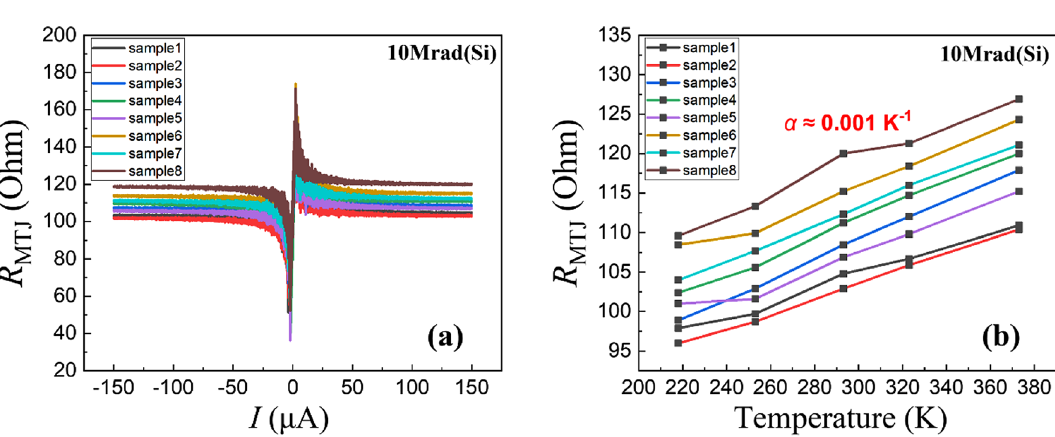
Figure 5. ( a ) Current induced switching characteristics and ( b ) temperature dependence of resistance of MTJs (sample1 ~ sample8) after radiation with 10 Mrad(Si) total ionizing